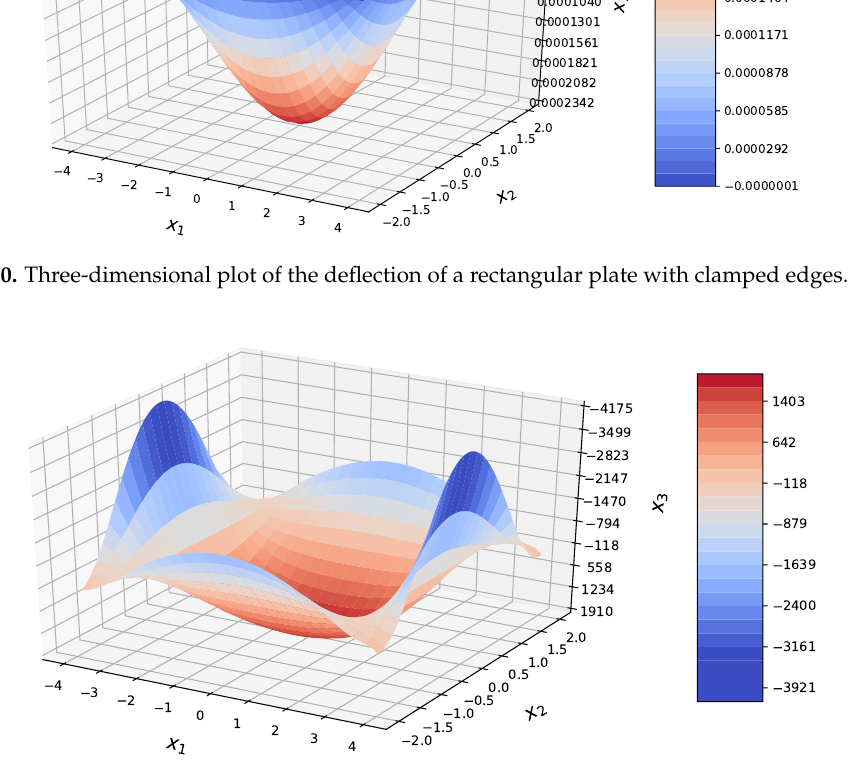
Figure 21. Three-dimensional plot of the bending moment M 11 of a rectangular plate with clamped